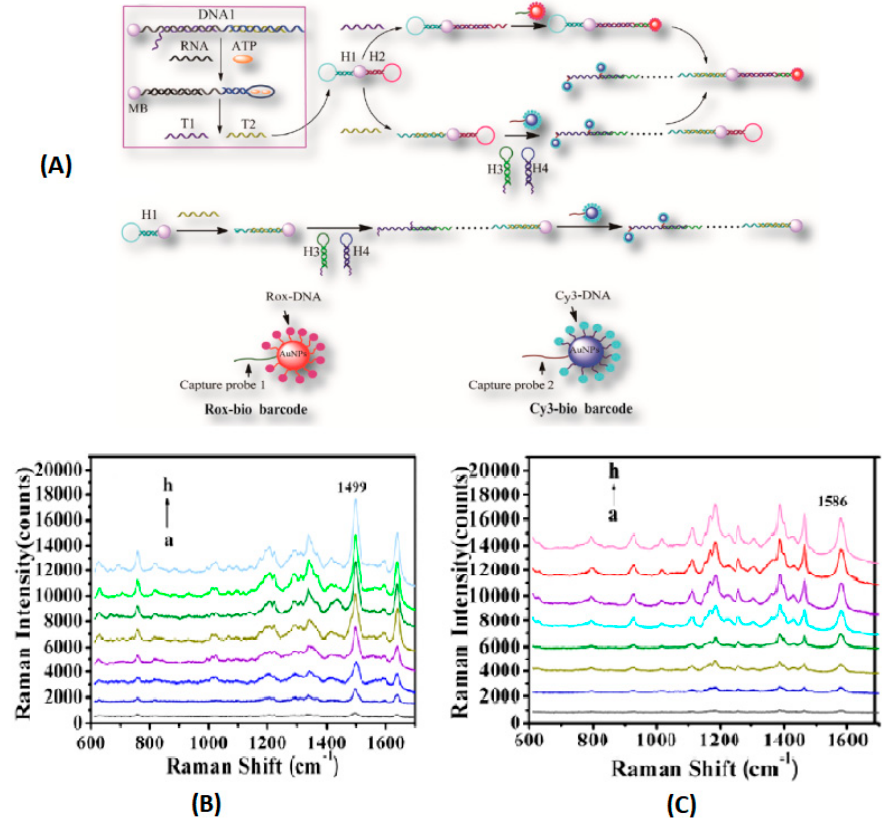
Figure 3. ( A ) Illustration of the asymmetric signal amplification SERS assay and process of HCR. ( B ) SERS spectra for increasing concentrations of ATP (a, 0; b, 1.0 × 10 − 7 ; c, 5.0 × 10 − 7 ; d, 1.0 × 10 − 6 ; e, 5.0 × 10 − 6 ; f, 1.0 × 10 − 5 ; g, 5.0 × 10 − 4 ; h, 1.0 × 10 − 4 M). ( C ) SERS spectra for increasing concentrations of miR-203 (a, 0; b, 1.0 × 10 − 15 ; c, 5.0 × 10 − 15 ; d, 1.0 × 10 − 14 ; e, 5.0 × 10 − 14 ; f, 1.0 × 10 − 13 ; g, 5.0 × 10 − 13 ; h, 1.0 × 10 − 12 M). (Ye et al. [50]).